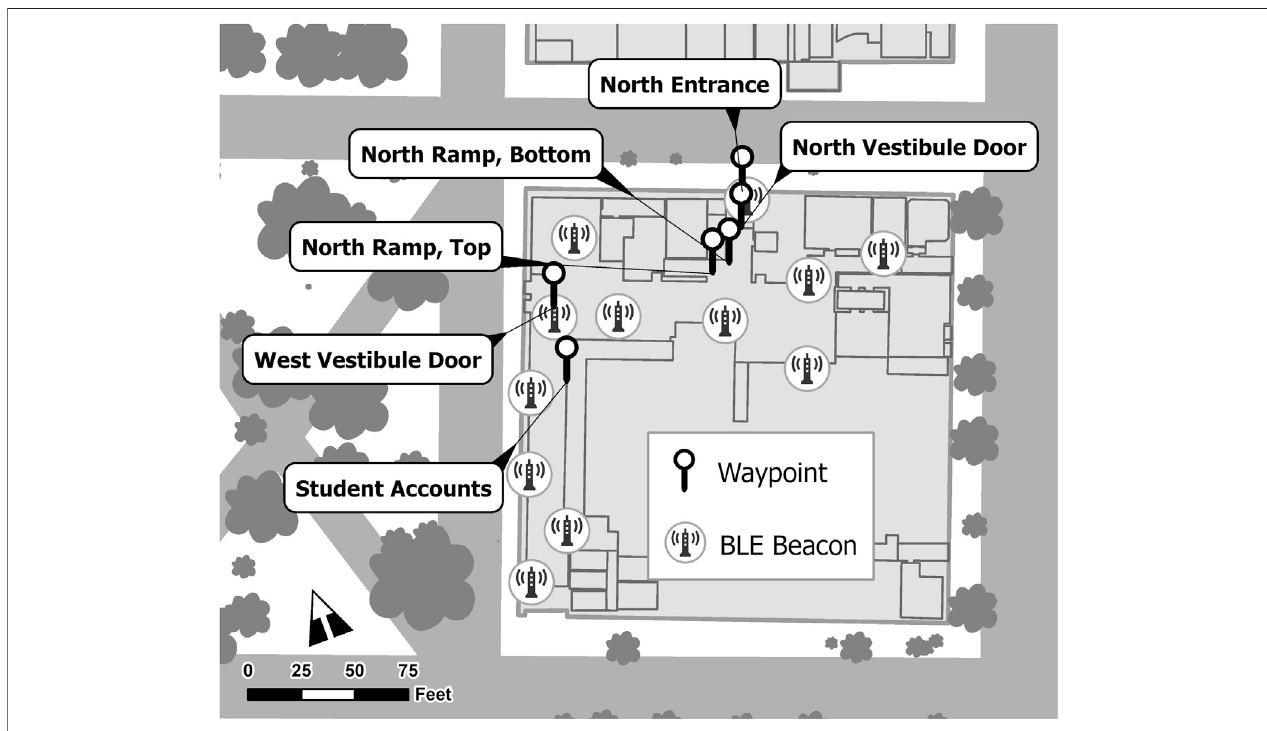
FIGURE 7 | Map of the location of Bluetooth Low Energy (BLE) beacons as well as the name and location of waypoints for Route A in the Fariborz Maseeh Hall (FMH) building. The Student Accounts desk and a conference room in FMH served as destinations for two of our routes (i.e., Route A and Route C; not